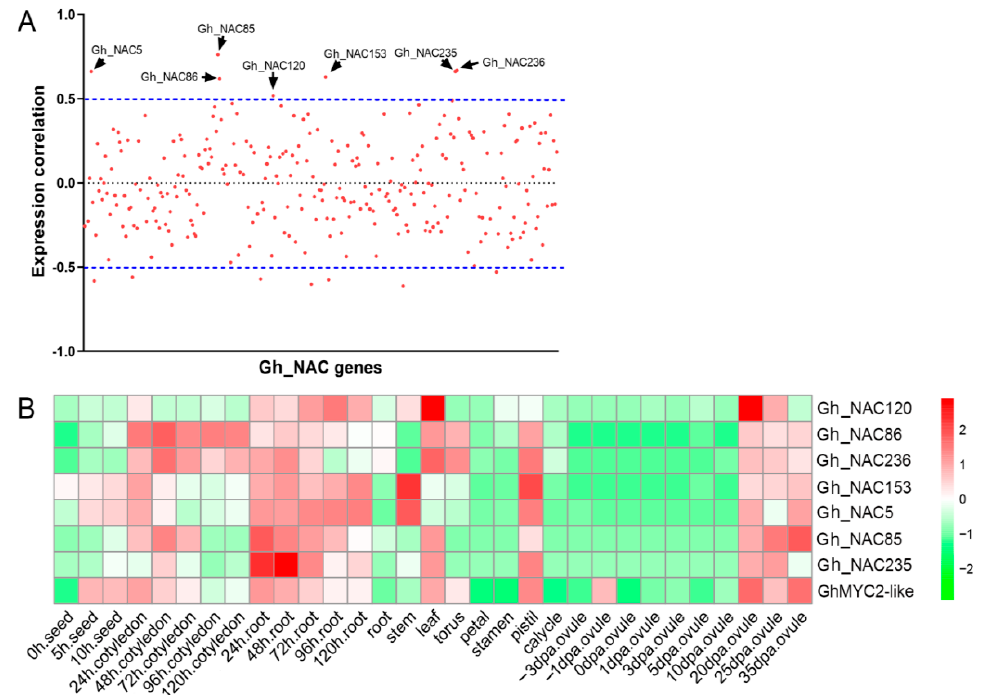
Figure 4. Expression correlation analysis of GhMYC2-like and NAC genes. ( A ) Distribution of expression correlation. The red dots indicate genes. Black arrows indicate the genes co-expressed with GhMYC2-like ( B ) Relative expression levels of GhMYC2-like and 7 NAC genes in different tissues and development stages of TM-1. Dpa: Day Post Anthesis.